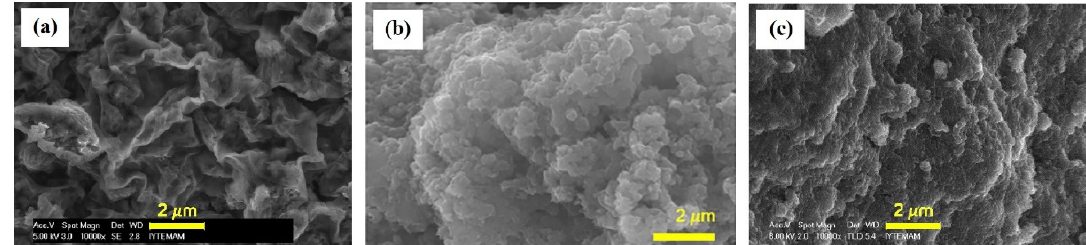
Figure 7. SEM images of PANI/CHT composites (in their powdered form) that were synthesized in various acid media: ( a ) CH 3 COOH, ( b ) HCl, ( c ) H 2 SO 4 medium. Panels ( a , c ) reprinted with permission from [84]. Copyright 2011, Elsevier. Panel ( b ) reprinted with permission from [85]. Copyright 2018, Wiley Online Library.